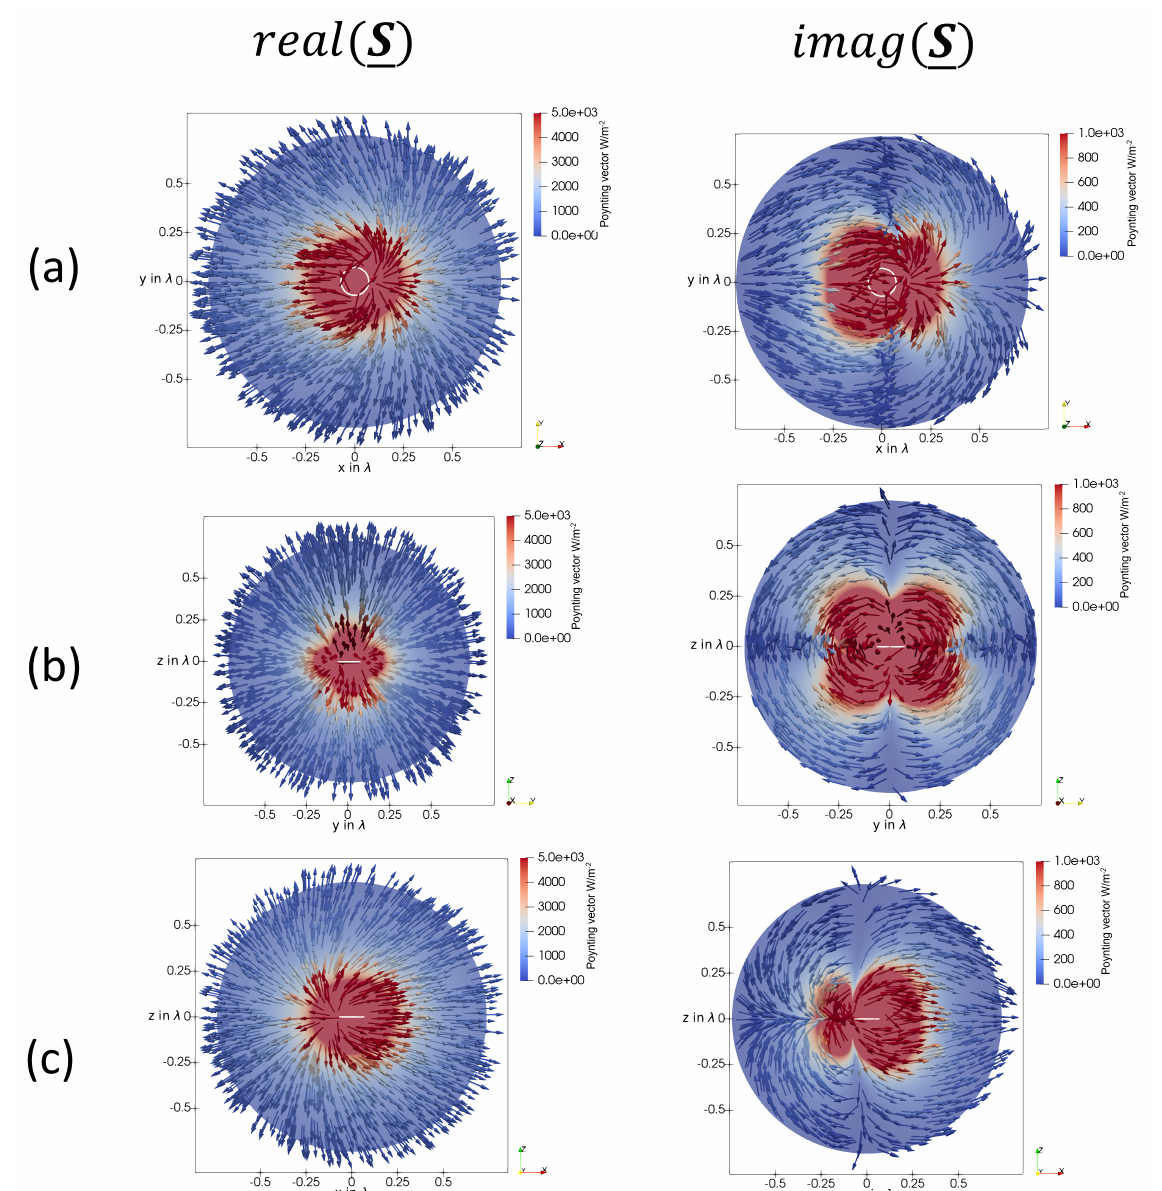
Figure 21. ( a ) The real and imaginary part of the Poynting vector in the xy-plane of a loop antenna with an overall circumference of 0.45 λ . ( b ) The real and imaginary part of the Poynting vector in the yz-plane of a loop antenna with an overall circumference of 0.45 λ . ( c ) The real and imaginary part of the Poynting vector in the zx-plane of a loop antenna with an overall circumference of 0.45 λ . In each sub-figure, the loop antenna is indicated as a white